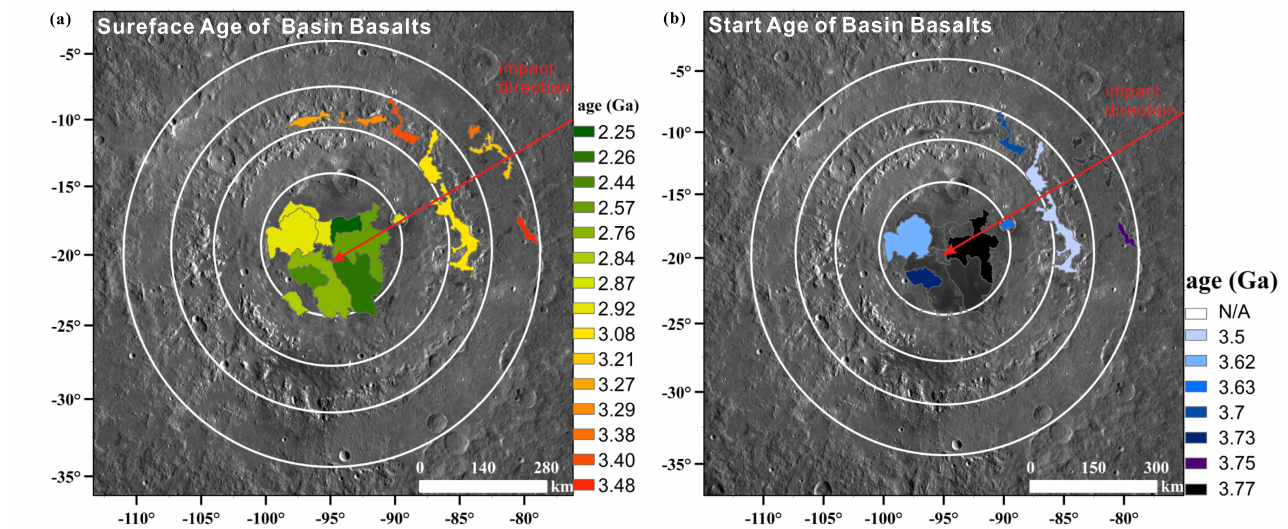
Figure 9. Relationship between impact direction and basalt